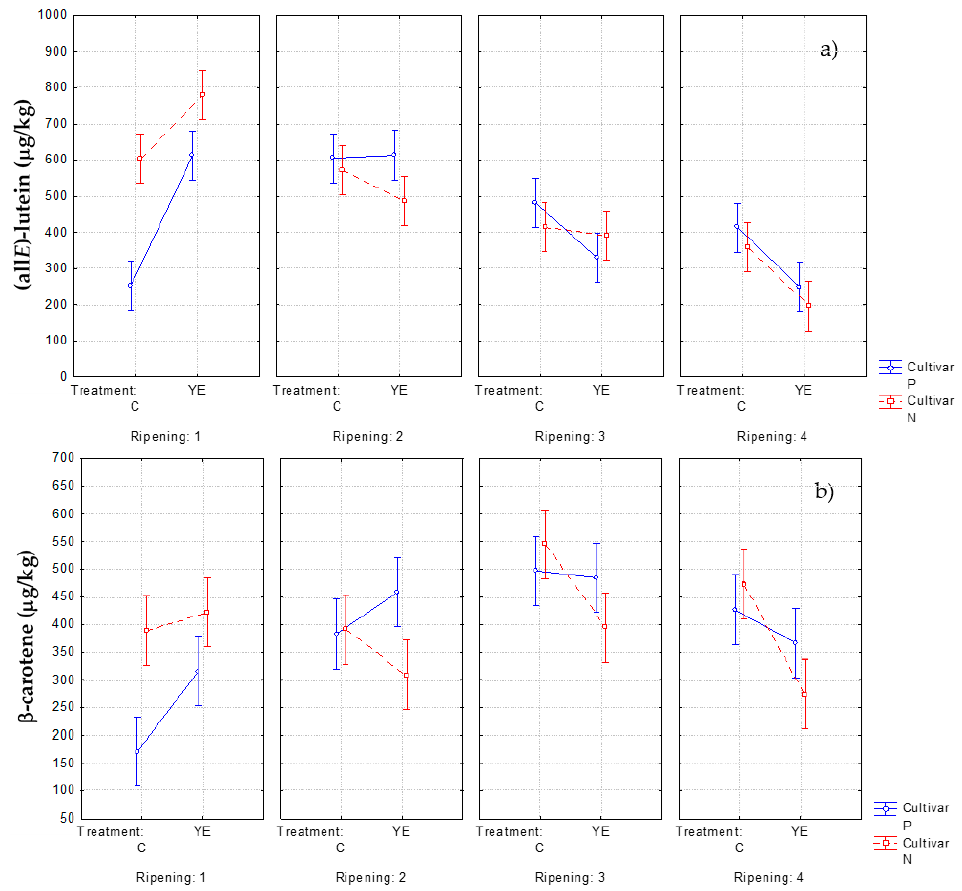
Figure 5. (all E )-lutein ( a ) and β -carotene ( b ) contents in yeast extract-treated (YE) and control (C) Negro Amaro and Primitivo wine grapes during ripening.